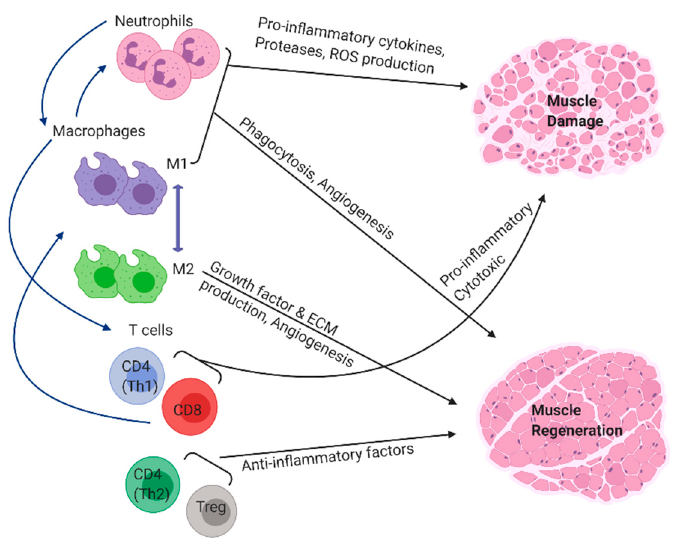
Figure 2. Inflammatory cells of the innate and adaptive immune system participate in the process of muscle regeneration and repair. Blue arrows indicate immune cells recruiting each other through the secretion of various soluble mediators.